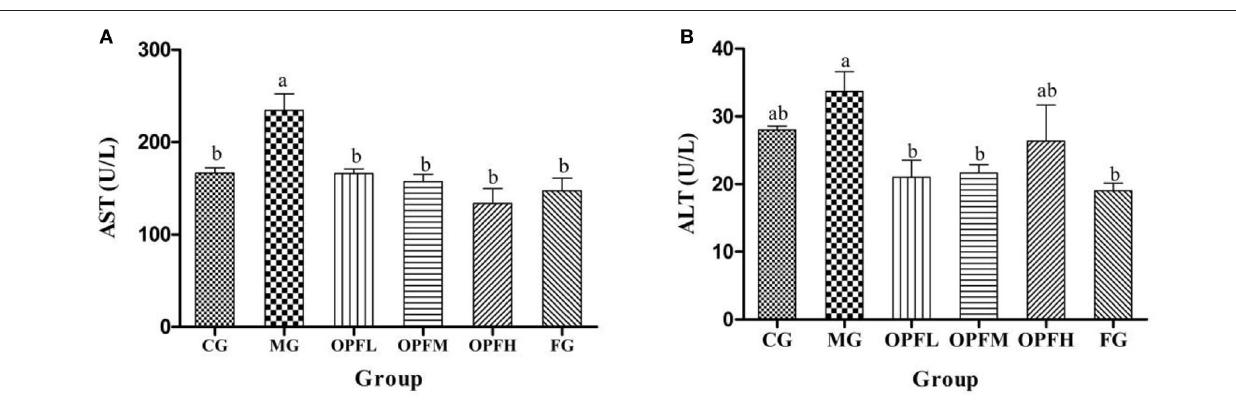
FIGURE 8 | Effects of different doses of OP-Fe 2 + and FeCl 2 on (A) AST and (B) ALT levels in serum. Different letters show statistically significant differences ( p < 0.05). The same letter in different groups indicates the absence of a statistical difference between these groups ( p > 0.05). The same is true in